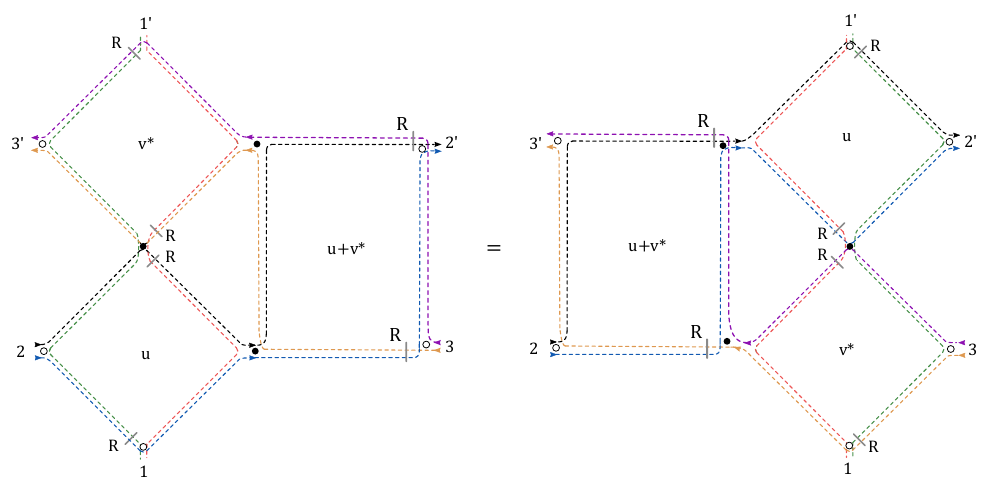
Figure 13 . Diagrammatic representation of the equation (3.21). Different colors refer to different spinorial structures, black blobs indicate corresponding integrations and circles indicate external coordinates without any integration. Letters u, v, u + v ∗ refer to the spectral parameters carried by the R-operators